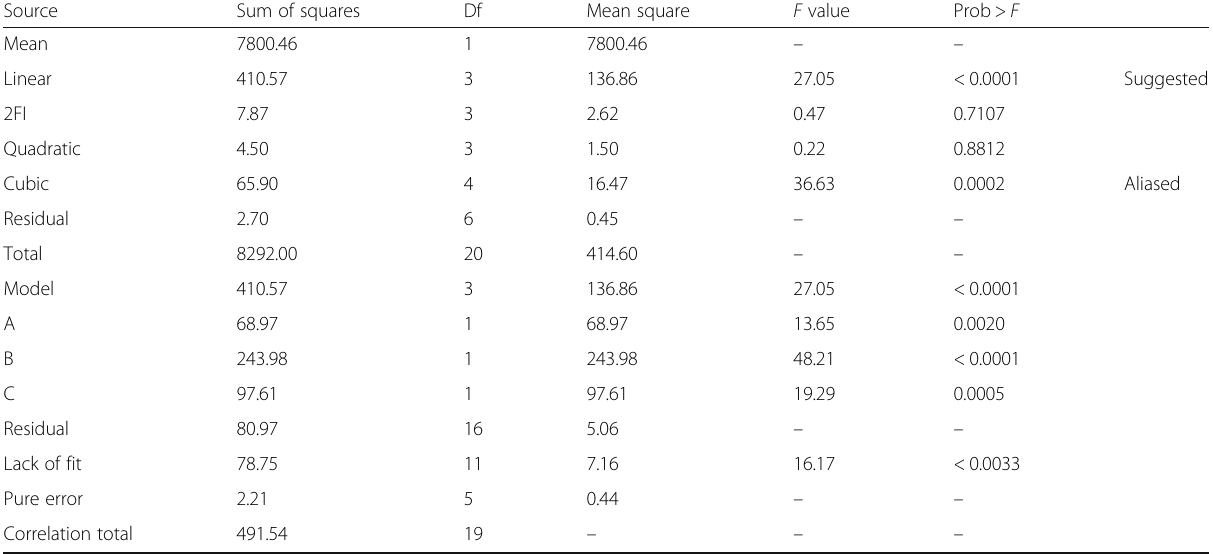
Table 5 Sequential model sum of squares and ANOVA for response surface linear model for pectin extraction